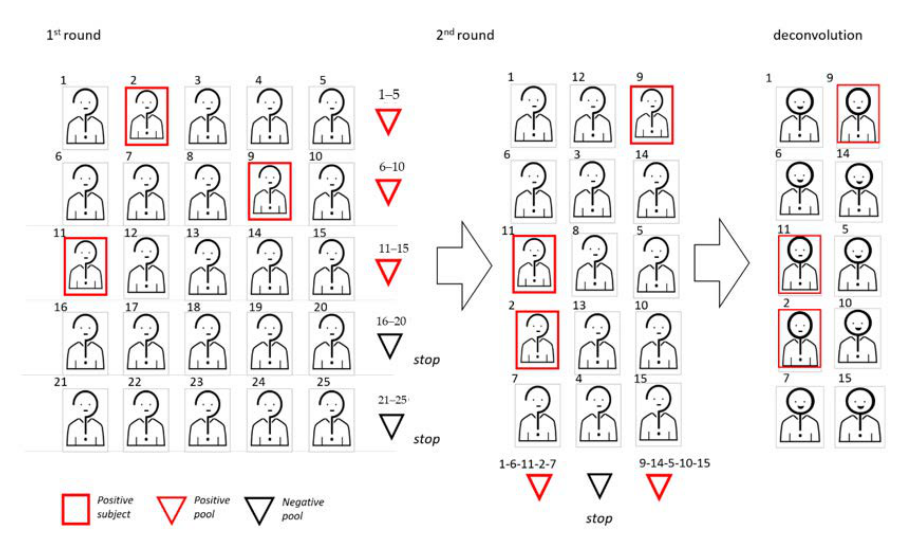
Figure 4. Graphic representation of the 2D sequential pooling approach. In this example, the cohort dimension is 25 and the pool size is 5. To begin, samples are arranged on a matrix and used to create five pools following the rows. Among these first-round pools, two turn out to be negative. The 15 remaining subjects are then rearranged in 3 vertical pools. Since two pools give a positive result, 10 validation tests are